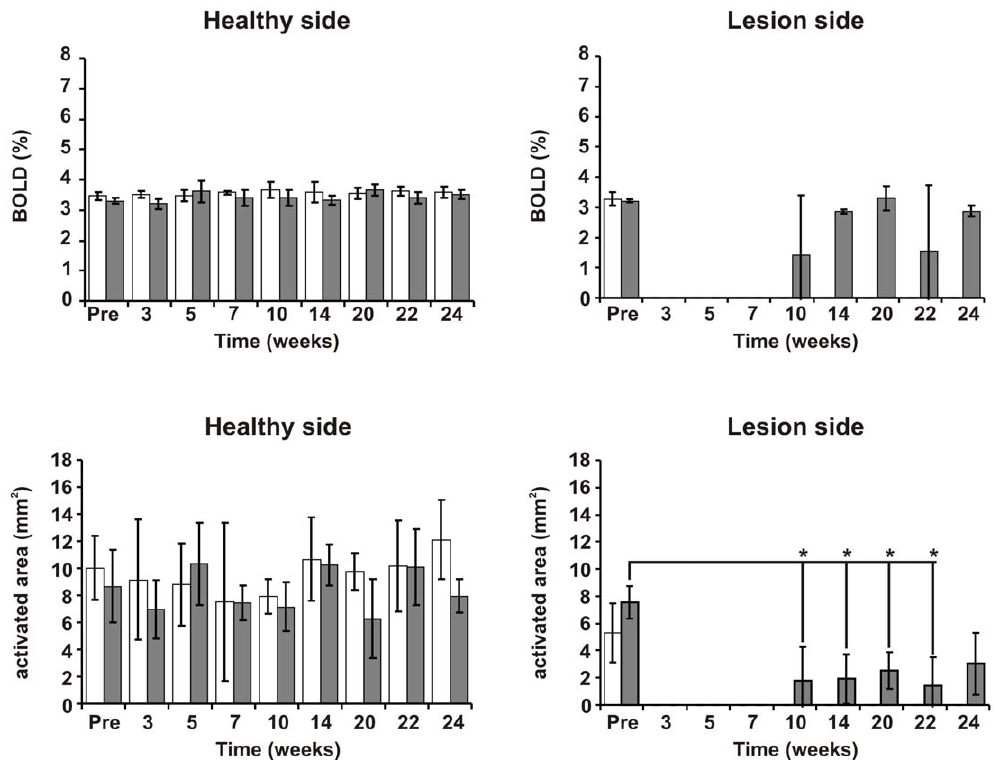
Figure 6. Quantitative analysis of fMRI data during recovery. Top row , percent change of signal intensity (BOLD effect) during stimulation of the forepaw (mean value 6 standard deviation) for the healthy (left plot) and affected (right plot) hemispheres of the brain, for the control group (white bars), and for the two animals treated with stem cells that regained BOLD signal in the affected hemisphere (dark gray bars). Bottom row , activated volume (in mm 3 ) in the primary somatosensory cortex in the healthy (left) and affected (right) hemispheres.